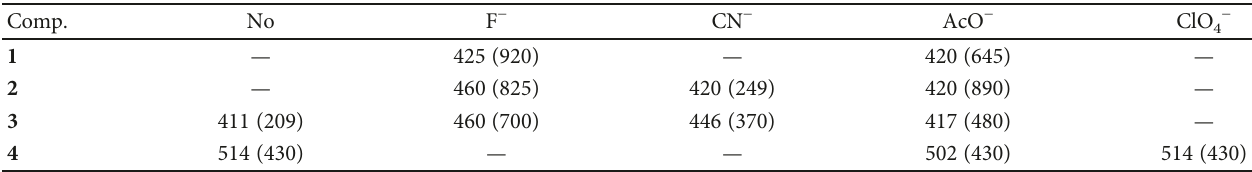
Table 2: Changes in position ( λ fl anions (in the form of TBAX salts) ( 1 0 · 10 − 4 M ).